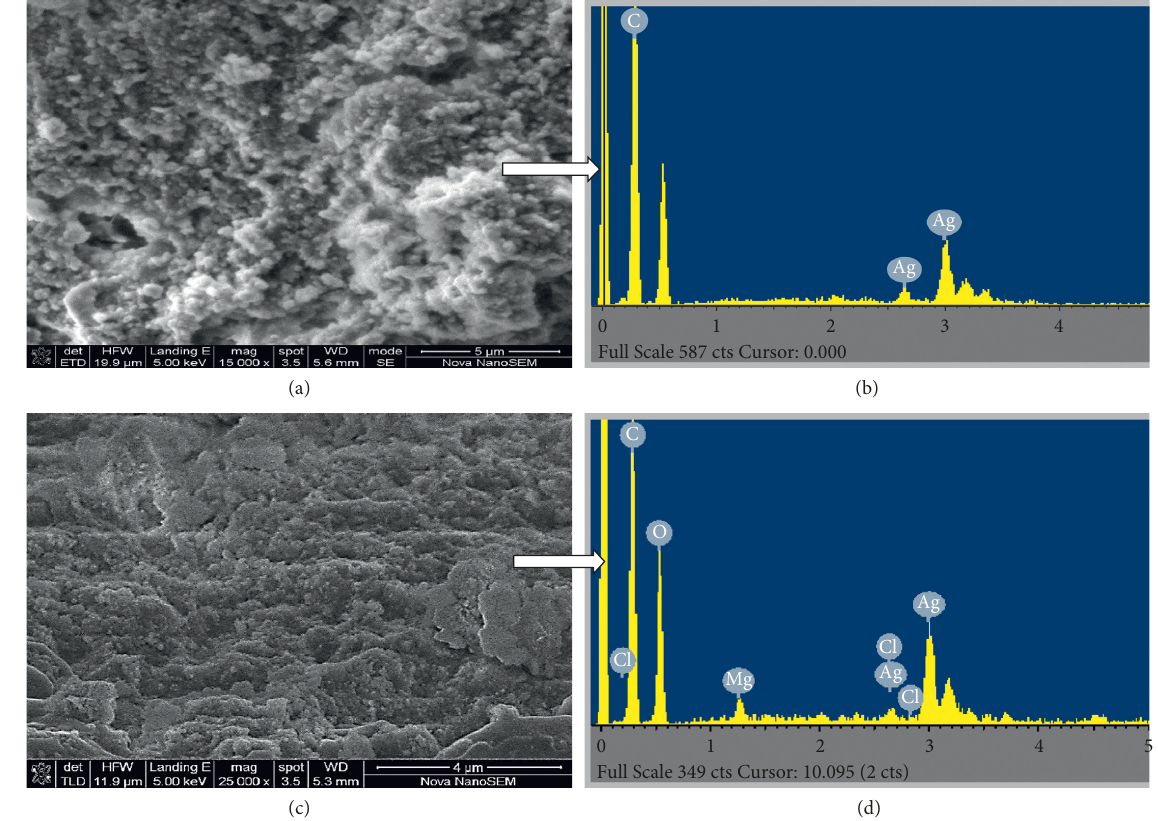
Figure 4: SEM images of biosynthesized (a) AgNps; (b) EDAX spectra of AgNps; (c) Ag-MgO nanocomposite; (d) EDAX spectra of Ag-MgO